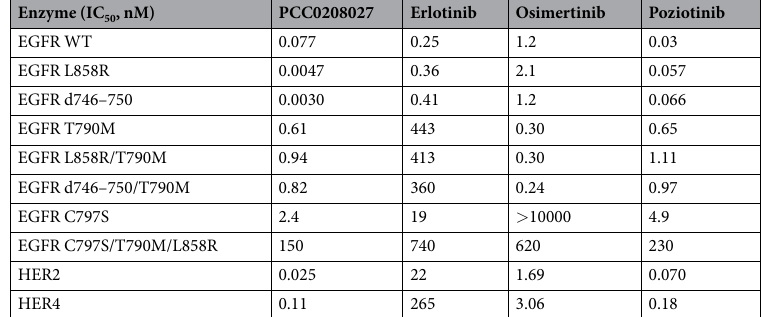
Table 1. Inhibition of EGFR family kinases by PCC0208027. IC 50 : 50% inhibition concentration. The IC 50 was calculated from data collected at concentrations ranging from 0.05 nM to 10 μ M (n = 2).